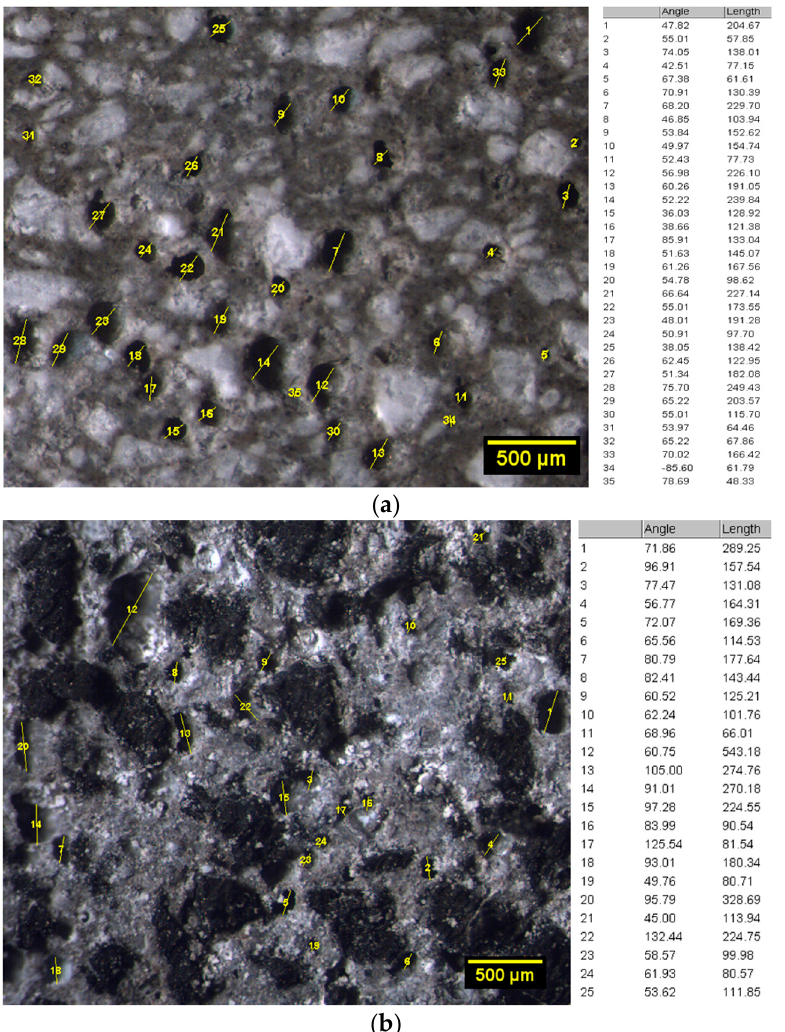
Figure 6. Optical microscopy image processing for pore size measurements: ( a ) CTR and ( b ) RP100 Figure 6. Opticalmicroscopyimageprocessingforporesizemeasurements: ( a )CTRand( b samples.